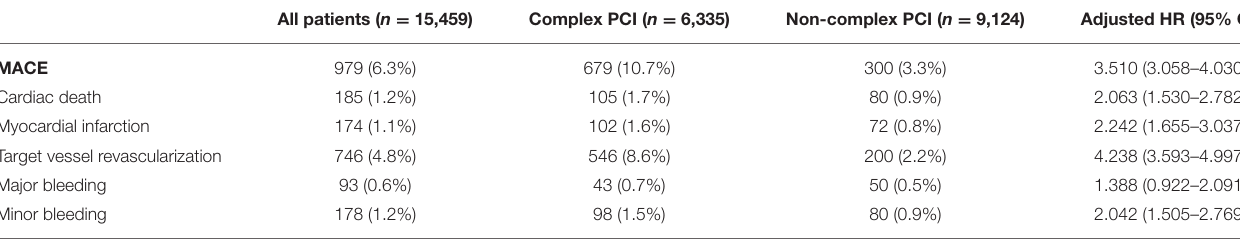
TABLE 3 | Clinical outcomes at 1 year of patients undergoing complex vs. non-complex PCI. All patients ( n = 15,459)